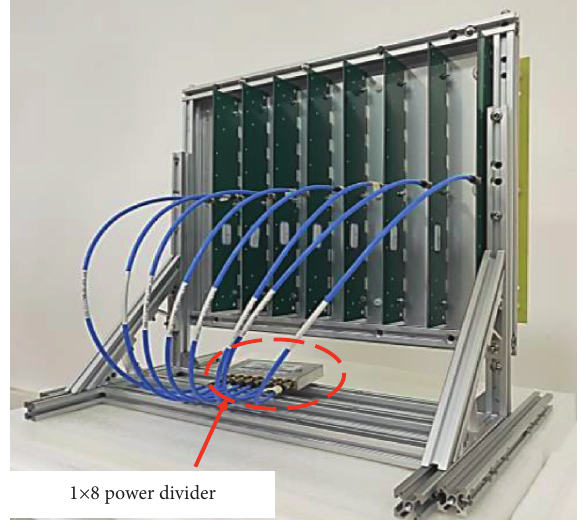
Figure 13: The measured scheme of the array with a power